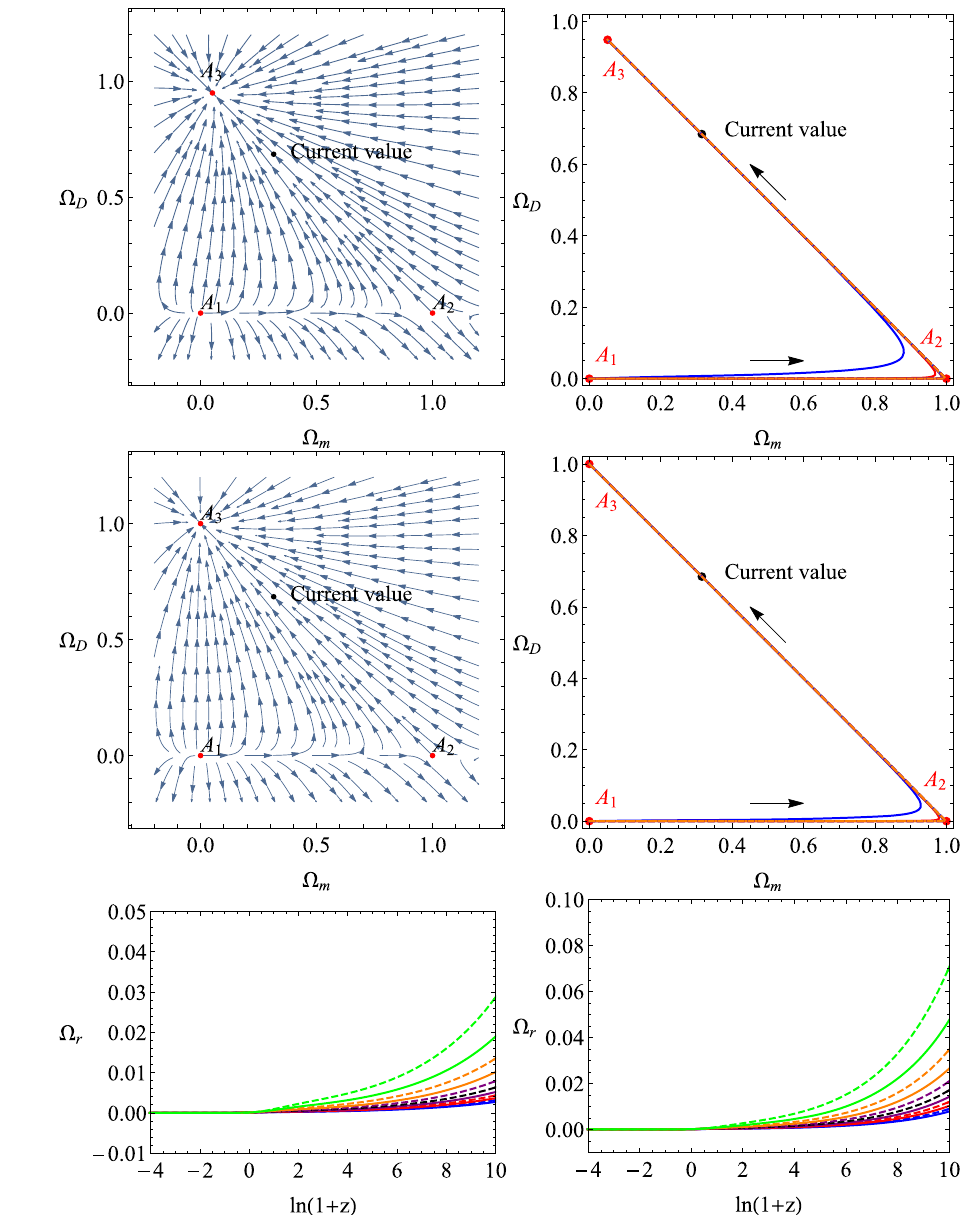
Fig. 21 Evolution curves of (cid:6) r for IBHDEHA with − 1 < β < 1. The left panel is plotted for (cid:5) = 0 . 8 and α = − 0 . 7, the right panel is for (cid:5) = 0 . 9 and α = − 0 .